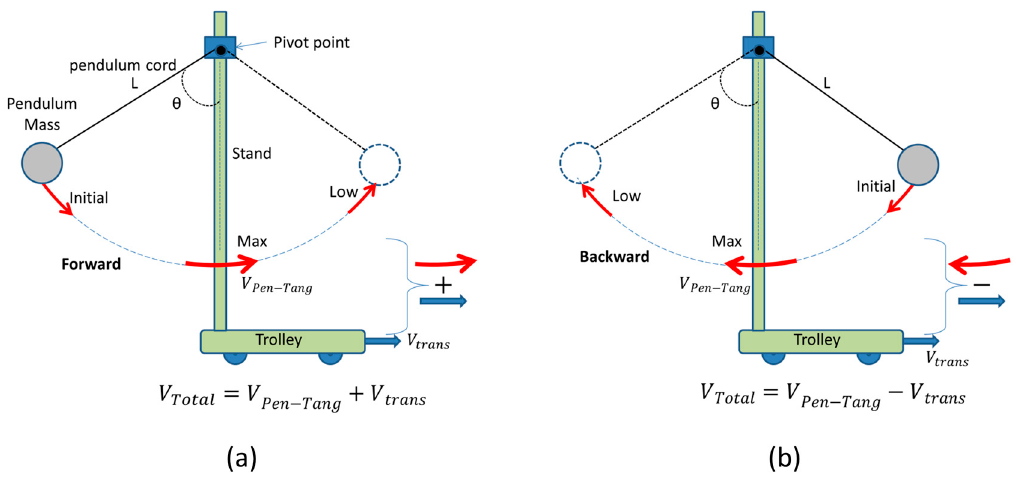
Figure 19. Pendulum swinging geometry with velocity analysis: ( a ) forward motion; and ( b ) backward motion.